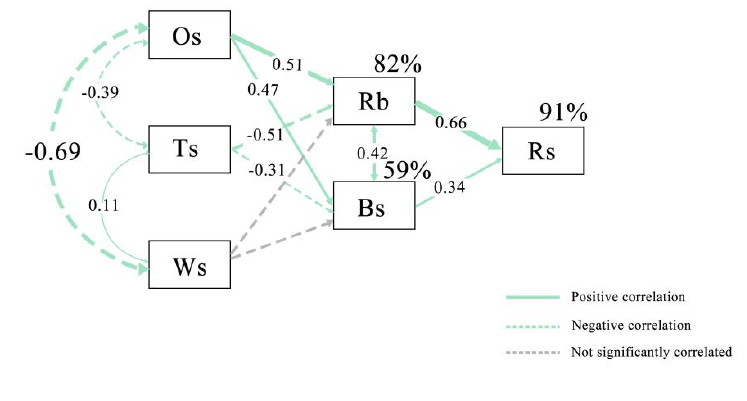
Figure 9. Driving mechanism of soil respiration rate change in structural equation model. Note: Rs, soil respiration rate; Ts, soil temperature; Ws, soil water content; Os, soil oxygen content; Bs, soil bacterial biomass; Rb, root biomass.